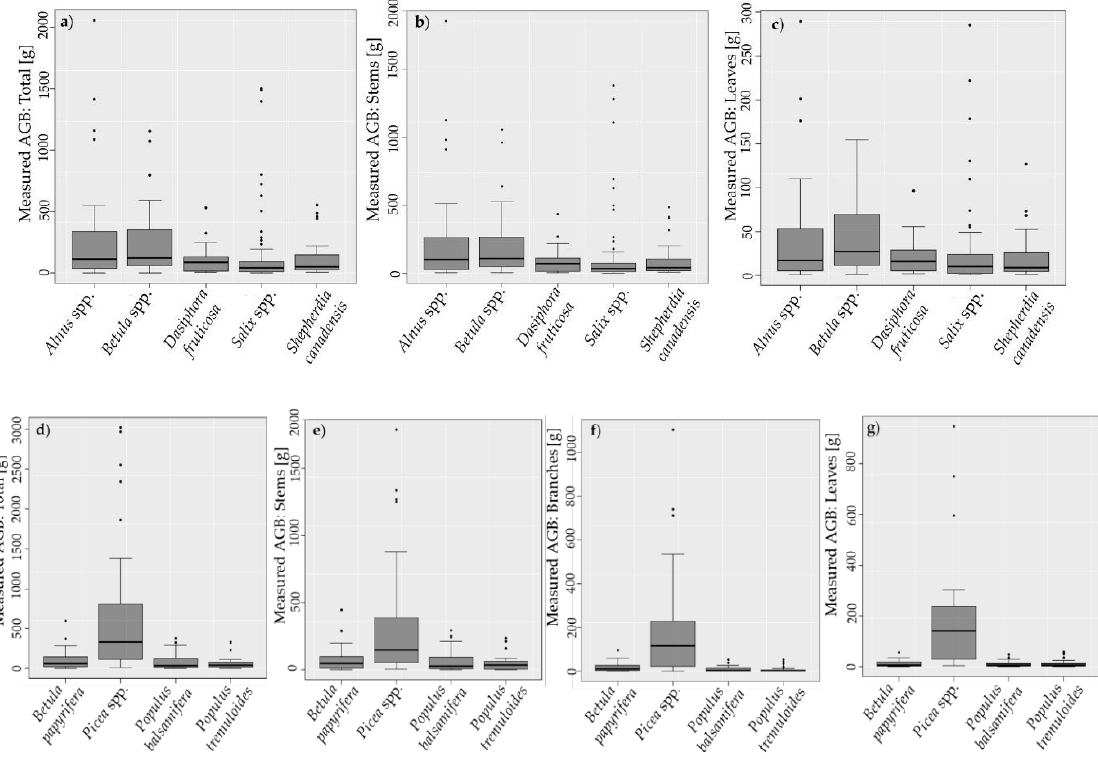
Figure 3. Boxplots of measured aboveground biomass [g] per plant component (total, stem, branch, and leaf aboveground biomass (AGB)) for common boreal ( a – c ) shrub and ( d – g ) short-stature tree genera/species. Points represent outliers of the